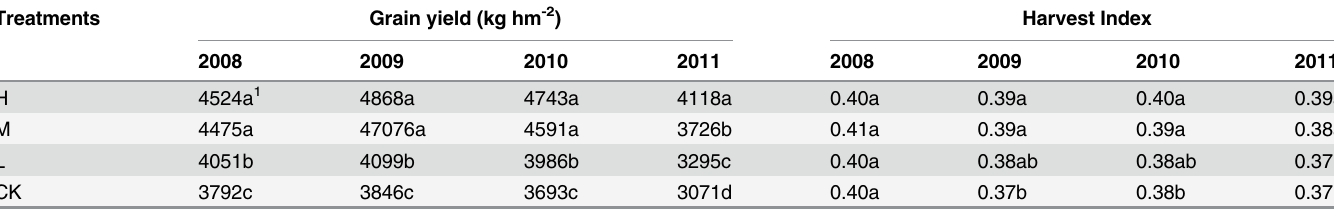
Table 5. Grain yields and harvest indexes under different wheat straw incorporation treatments from 2008 to 2011. Treatments Grain yield (kg hm -2